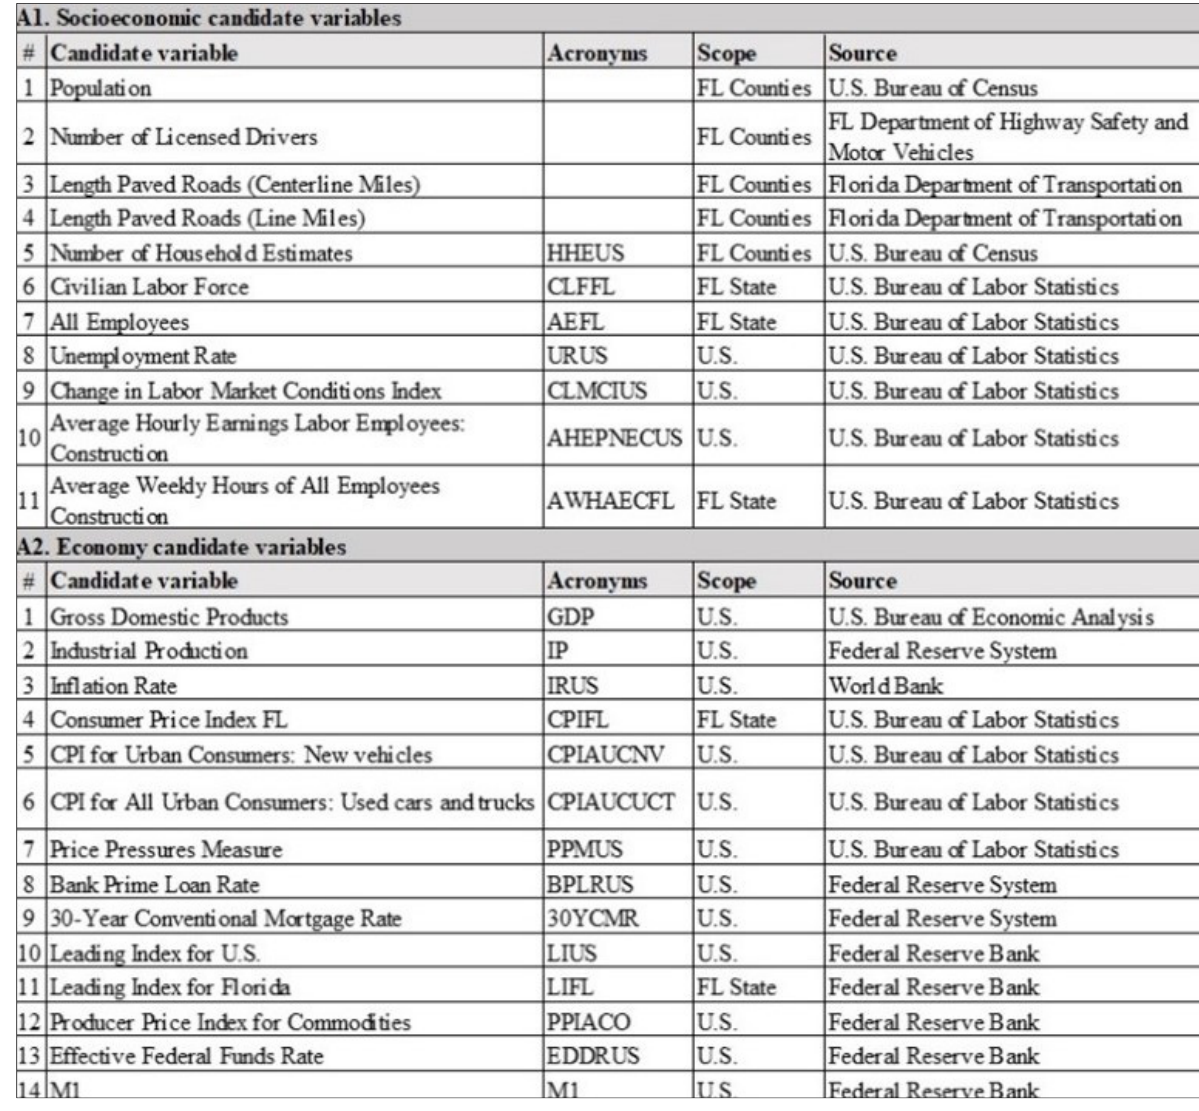
Figure A1. Independent variables employed in this research.